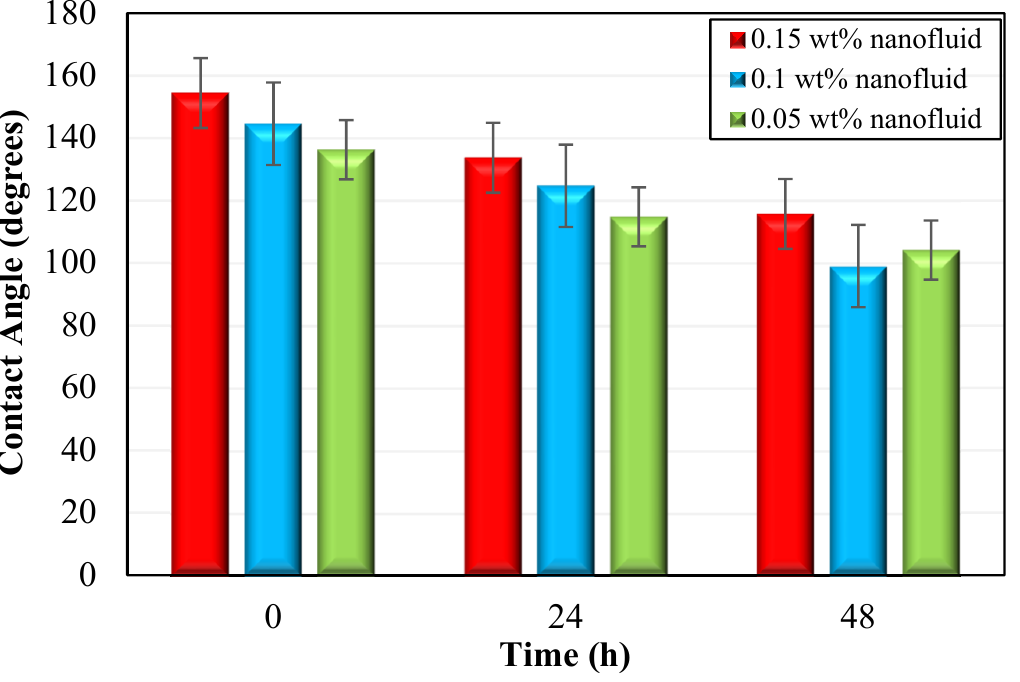
polymer solutions at various concentrations are shown in Tables 8 and 9, respectively.